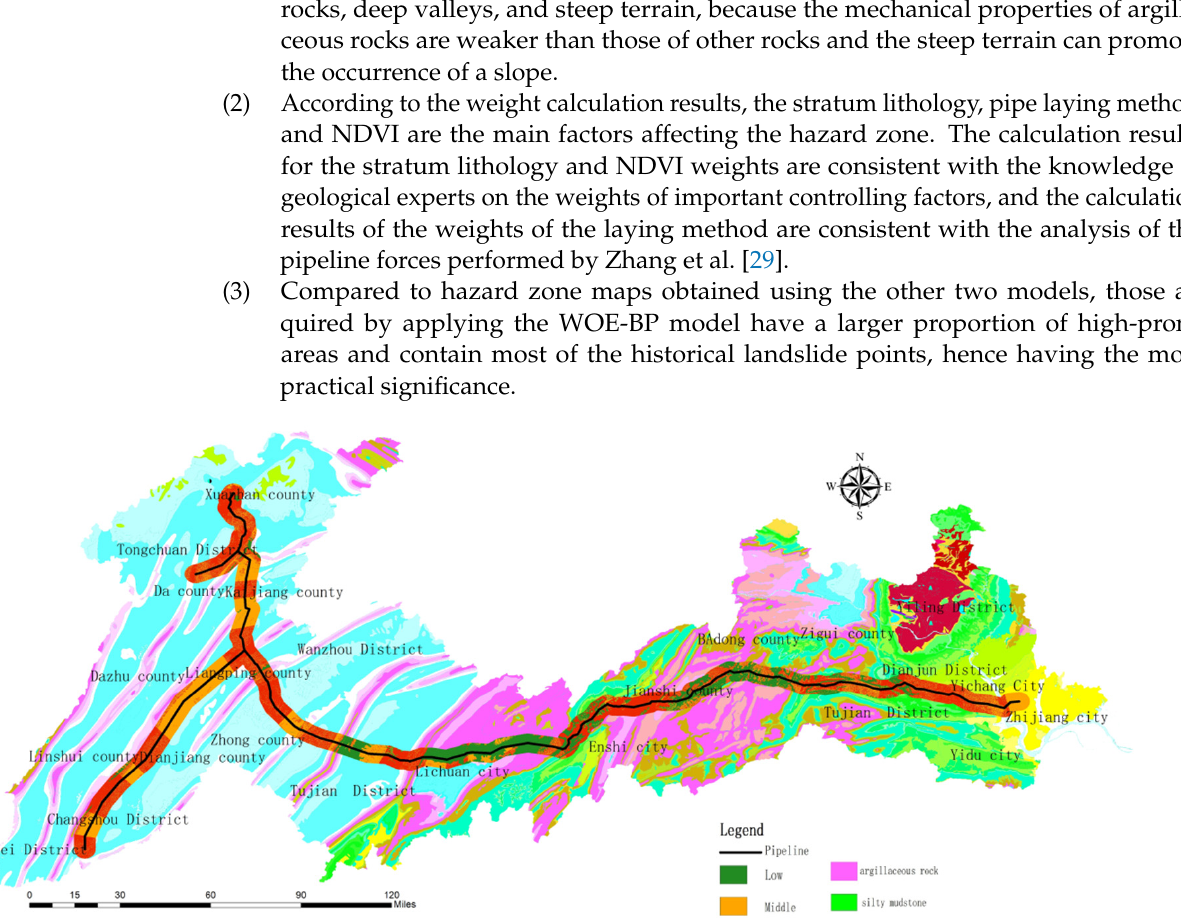
Figure 15. Hazard partition of the WOE-BP model.